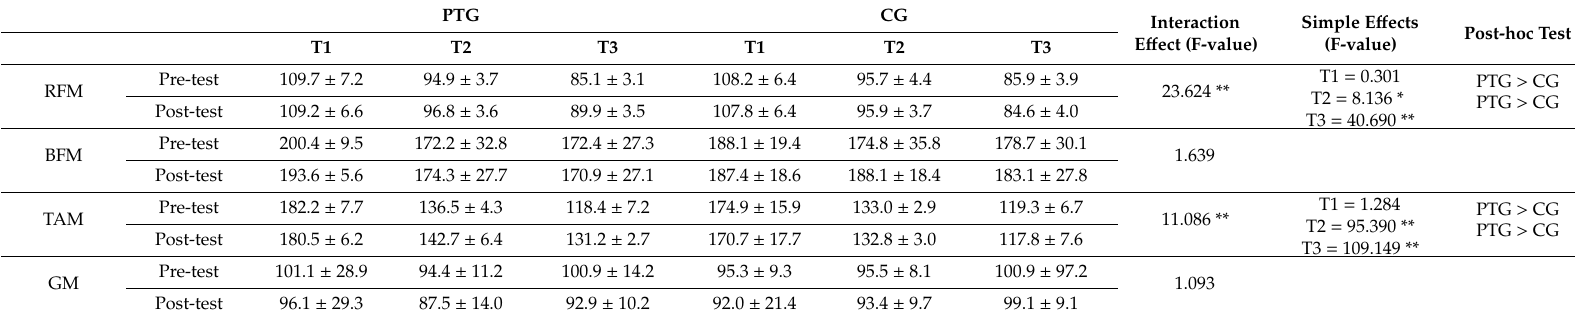
PTG: plyometric training group; CG: control group. The table indicates significant change (post–pre) when using the pre-test score as a covariate: * p < 0.05; ** p < 0.01. RFM: rectus femoris muscle; BFM: biceps femoris muscle; TAM: tibialis anterior muscle; GM: gastrocnemius